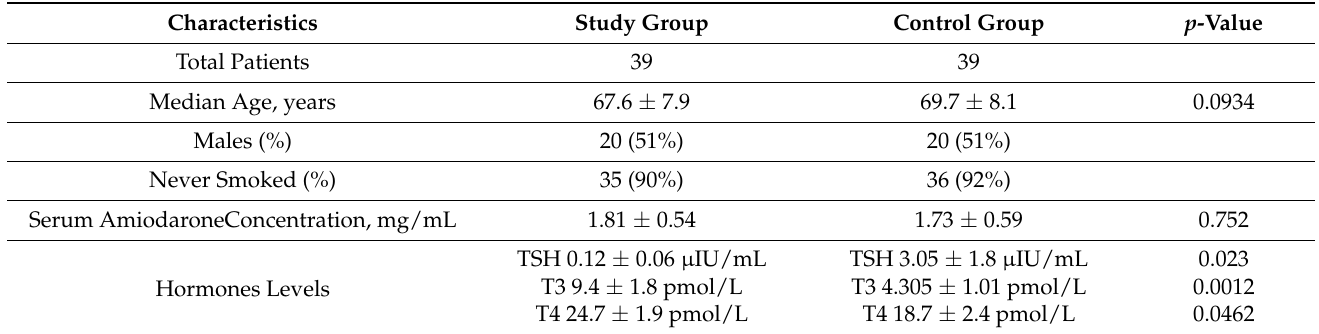
Table 1. The general characteristics of patients enrolled in this study. * p -values are estimated by Fisher’s exact